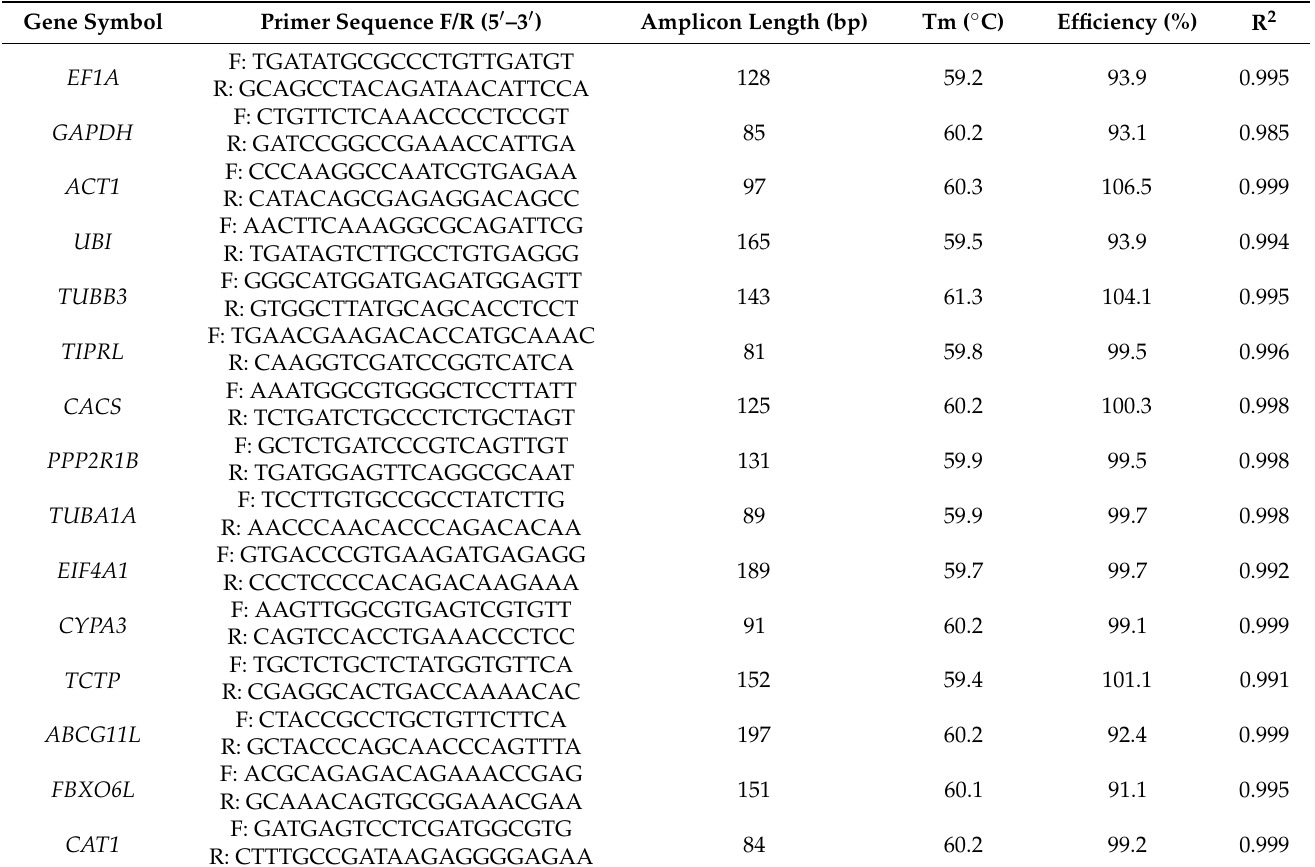
Table 1. Information of primers and amplicons for fourteen candidate reference genes and one target